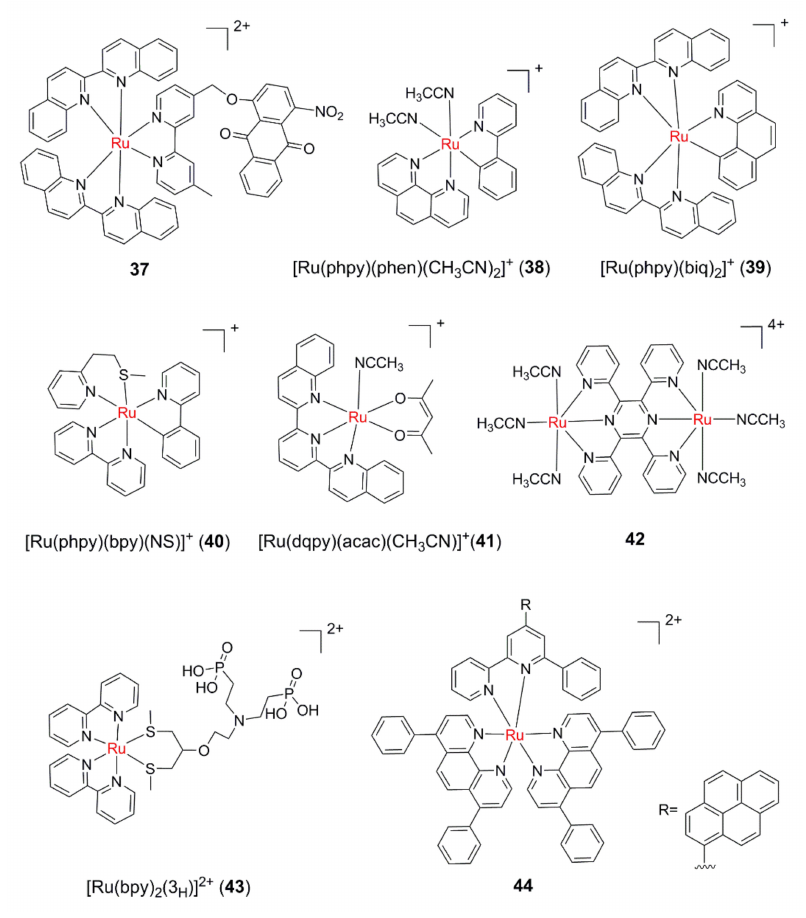
Figure 6. Photoactivatable Ru(II) polypyridyl complexes upon long-wavelength light irradiation. When the ring-metalized-ligands (such as 2-phenylpyridine, phpy) coordinate with Ru, the strong electron-donating capacity of carbon anions can significantly increase the t 2g orbital energy of Ru(II), thus greatly prolongs the MLCT absorption wavelength. Using this strat- egy, Turro’s group designed and synthesized the complex cis -[Ru(phpy)(phen)(CH 3 CN) 2 ] + ( 38 ) [79]. The MLCT absorption peak of Ru(II) to phen ligand was at 490 nm, and the tail band extended to the phototherapy window. The quantum efficiency of ligand exchange between CH 3 CN and Cl - was up to 0.25 upon 450 nm excitation. Different from the